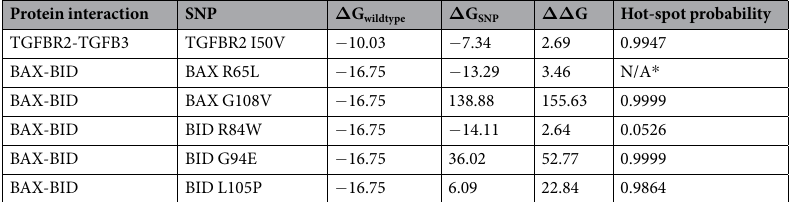
Table 1. Energy analysis of interface mutations in TGFBR2-TGFB3 and BAX-BID complexes. The first and second columns indicate the complex and the SNP affecting the interface. The next two columns show the Δ G calculated with Rosetta of the wild-type complex ( Δ G Δ G wild-type ) and the SNP mutant form ( SNP ). The third column shows the ( ΔΔ G = Δ G wild-type − Δ G SNP ) –energies are represented in Rosetta units, which are approximately the same as kcal/mol. The fourth column show the probability calculated by PCRPi-Webserver. * Residue not considered by PCRPi-Webserver as part of the